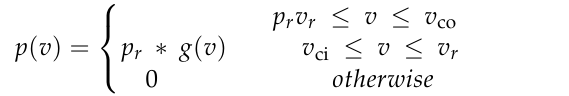
Figure 9. Energy density error of the nine models for Zafarana site.